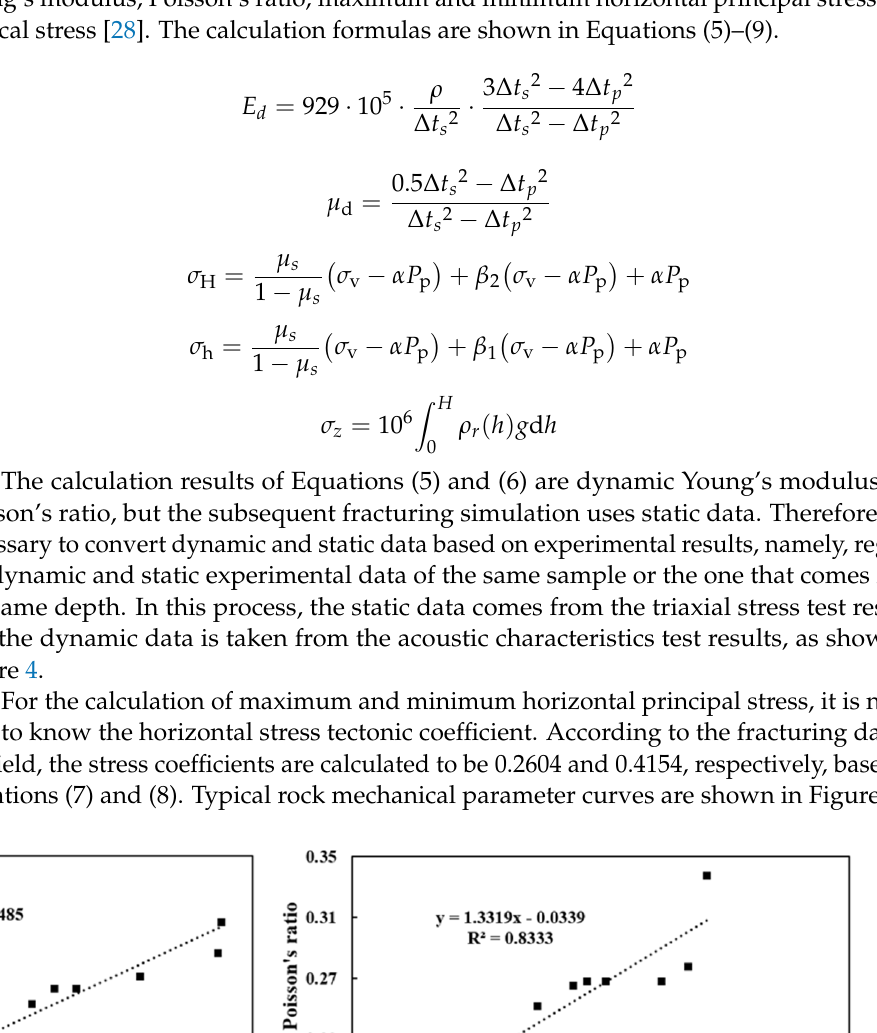
Figure 5. Curves of rock mechanics parameters. Surrounding rock of overlying and underlying strata and model boundary conditions are constructed. Based on a one-dimensional rock mechanics model, mechanical values are assigned to corresponding rocks. By using rock failure criterion and yield condition, finite element stress-strain simulation is applied to obtain a three- dimensional rock mechanics model of the S reservoir (Figure 6).